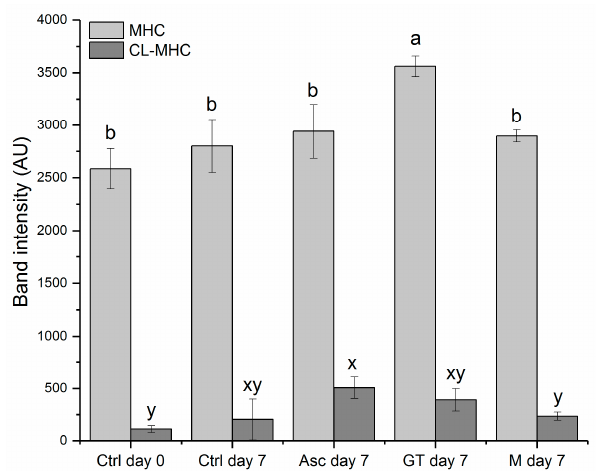
Figure 3. Band intensity of myosin heavy chain (MHC) and cross-linked MHC (CL-MHC) separated by SDS-PAGE in pork chops injected with neutral brine (Ctrl) and chill stored in high-oxygen modified atmosphere packaging (MAP) for 0 or 7 days, and pork loins injected with brine added 225 ppm ascorbate (Asc), green tea (GT, ~25 ppm gallic acid equivalents (GAE)), or maté extract (M, ~25 ppm GAE), and chill stored in high-oxygen (MAP) for seven days. Band intensity expressed as mean ± SD of three independent replicates. Means with different letters (a–b for MHC, and x–y for CL-MHC) differ significantly ( p < 0.05).